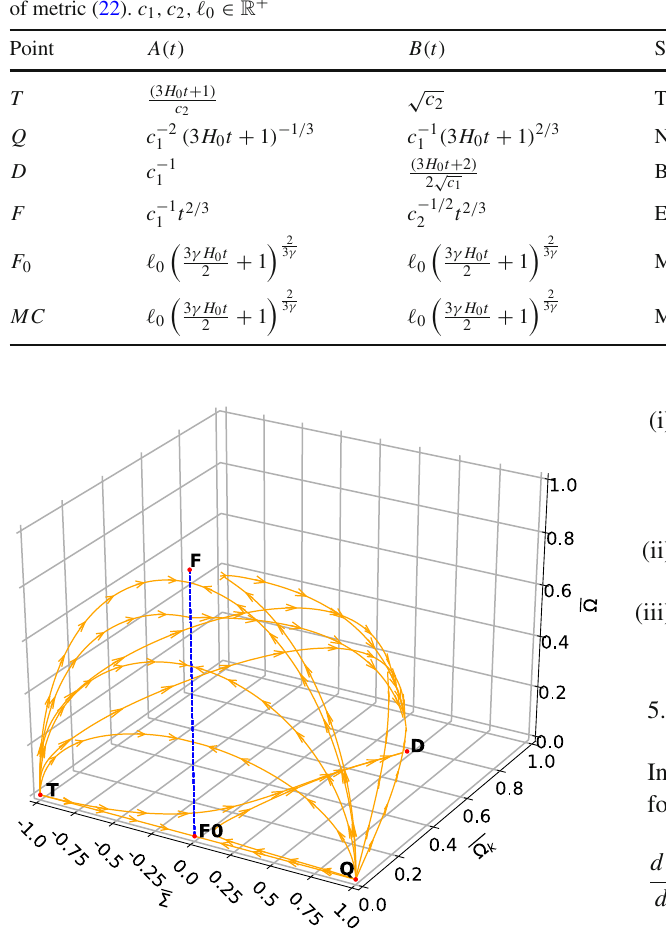
Table 1 Exact solutions associated with equilibrium points of reduced averaged system (78a), (78b) and (78c). A ( t ) and B ( t ) denote scale factors of metric (22). c 1 , c 2 ,(cid:16) 0 ∈ R +